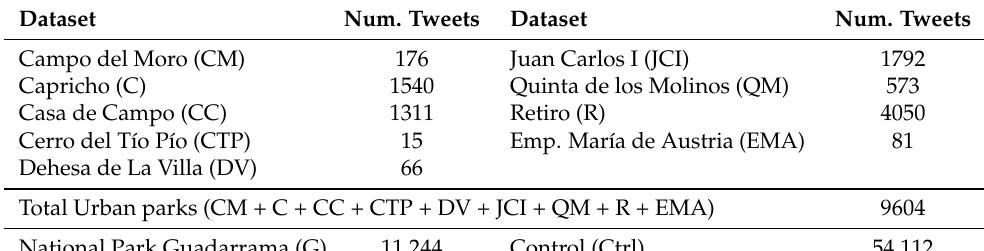
Table 2. Total amount of tweets per dataset after cleaning Dataset